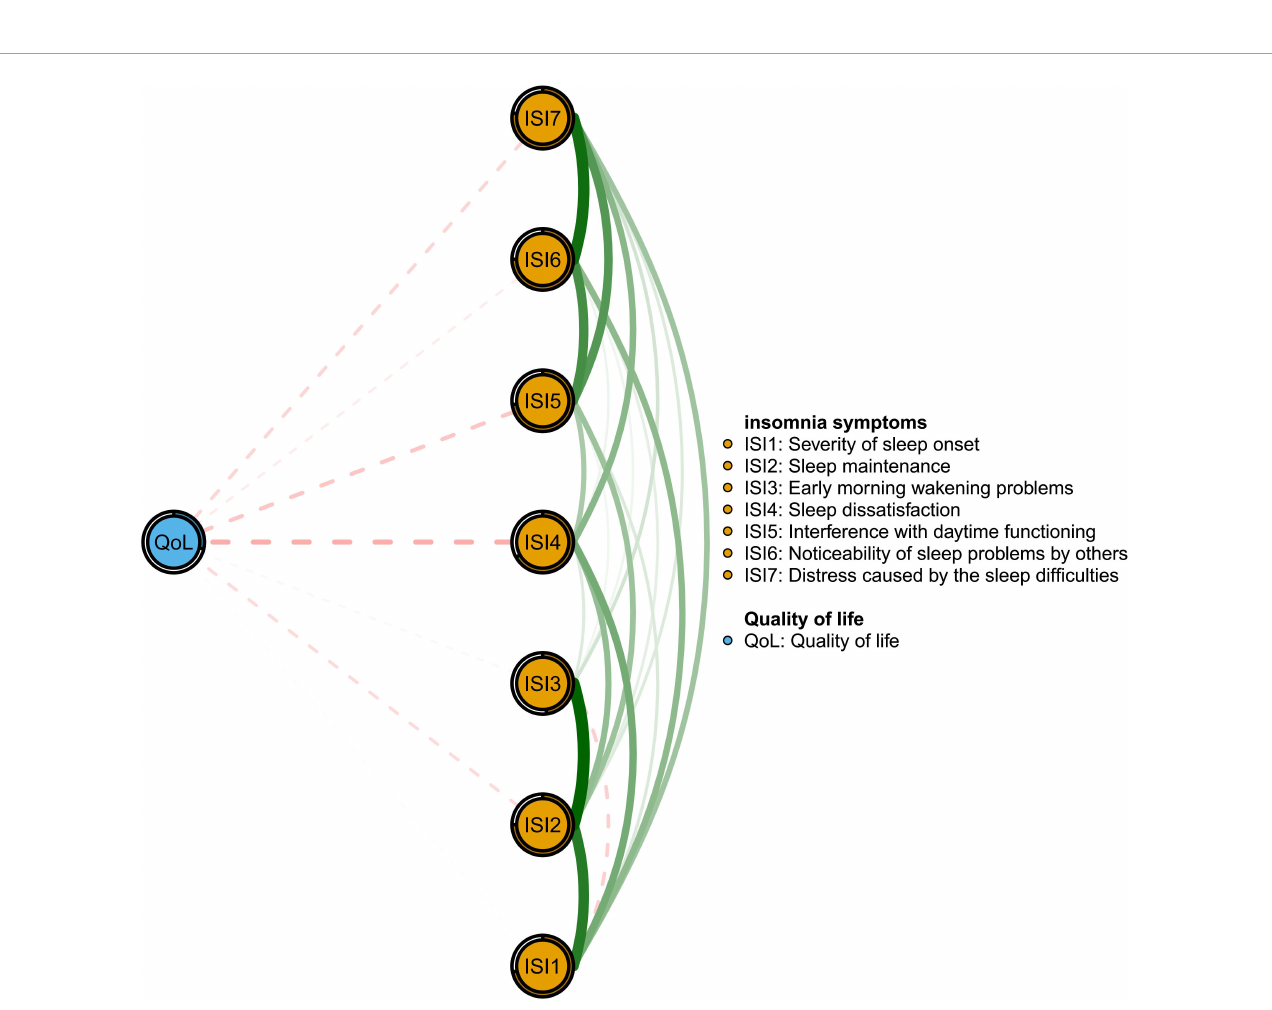
FIGURE2 Flow network of quality of life and insomnia